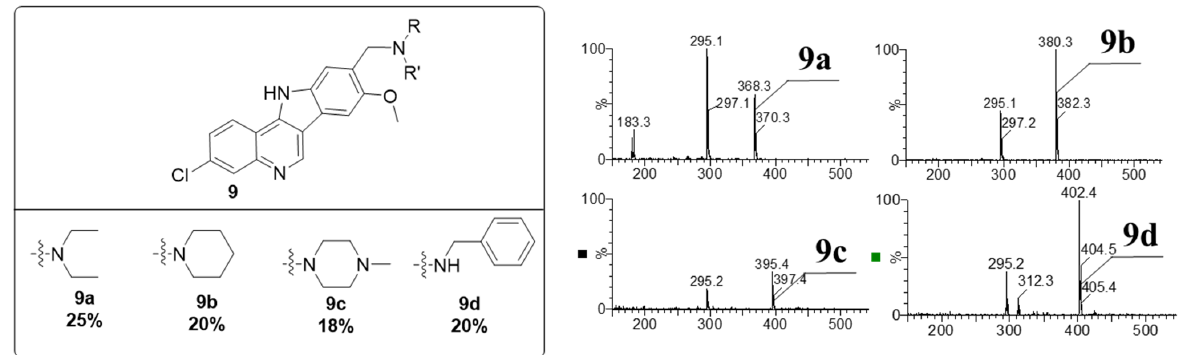
observed (vehicle normalized expression was noted to be 0.57 ± 0.36 and 0.55 ± 0.34), but significance was not noted. Compound 9b ’s normalized expression of 1.36 ± 0.94 was not notably different than either vehicle or untreated (0.99 ± 0.24) controls, in agreement with Figure 2. Structures and MS data for the four analogs generated in Scheme 1. Figure 2. Structures and MS data for the four analogs generated in Scheme 1. the luciferase and AsPc1 findings.